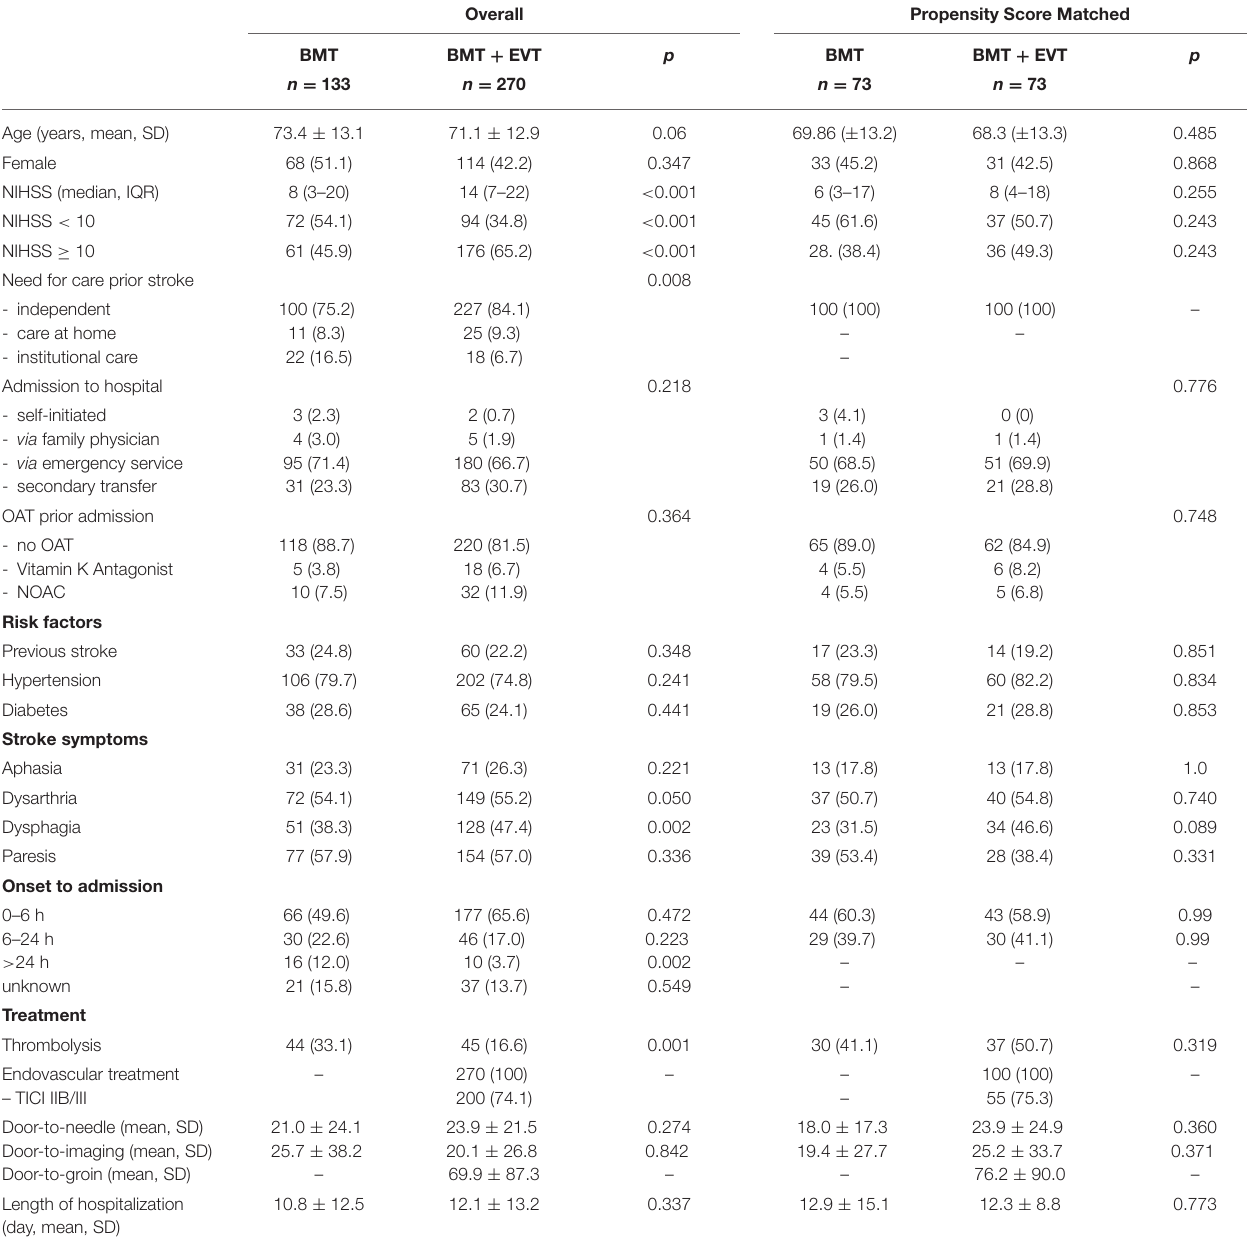
TABLE 1 | Baseline characteristics upon hospital admission and process